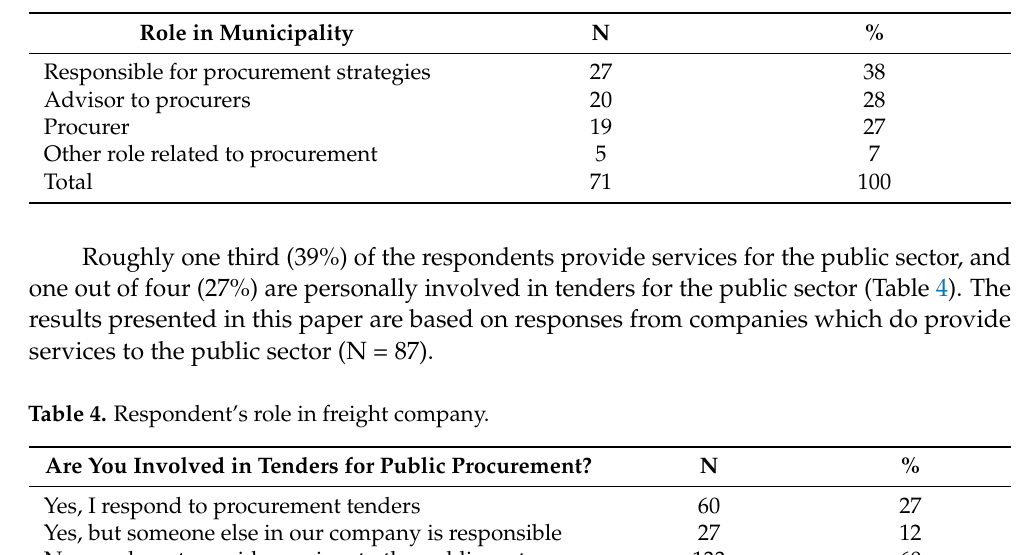
Table 3. Respondent’s role in municipality.